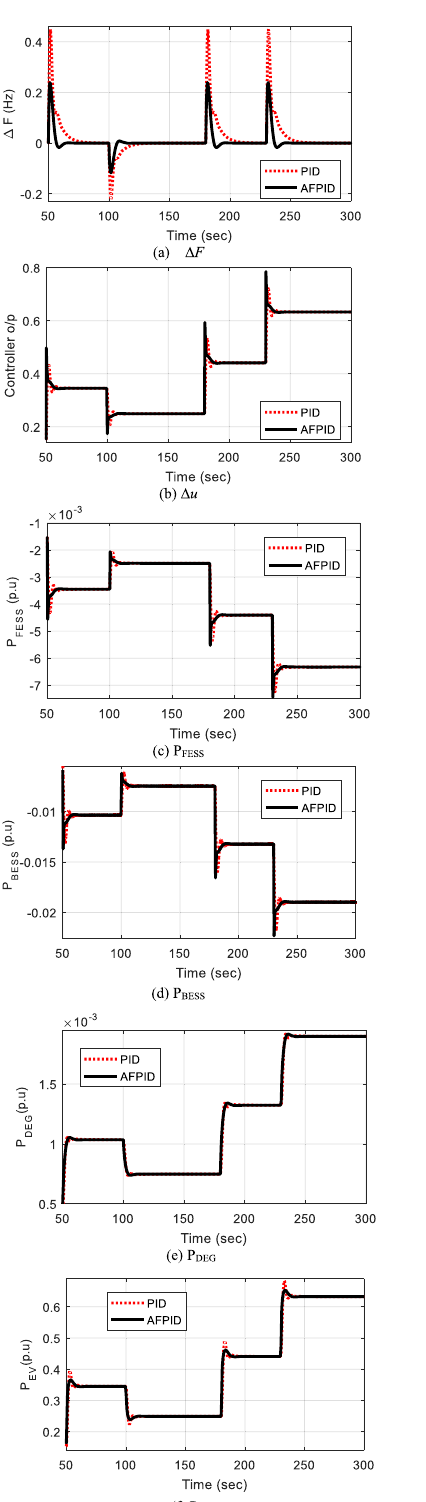
Fig. 11 System performance for case 2 a Δ F b Δ u c P FESS d P BESS e P DEG f P